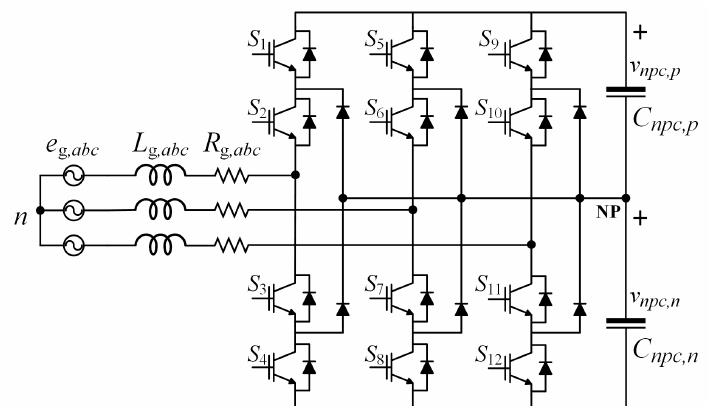
Figure 2. The circuit configuration of 3-level neutral-point clamped (NPC) AC/DC converter.